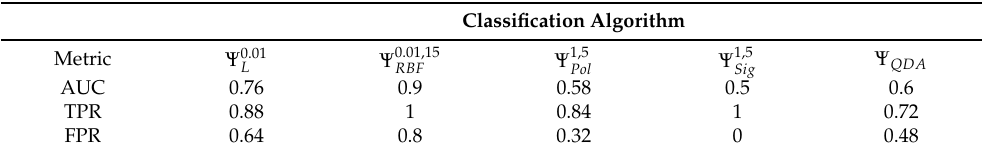
Table 6. Result of classification—before therapy vs. after therapy.